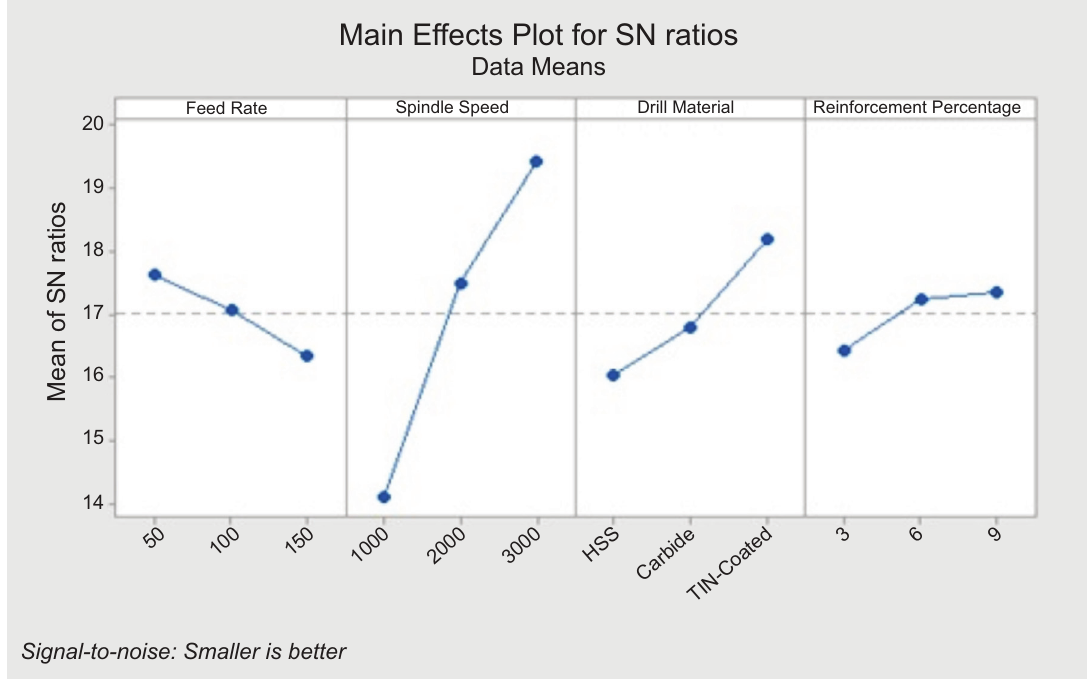
Fig. 9. Response graphs for burr height (LM6/B 4 C/Fly ash).